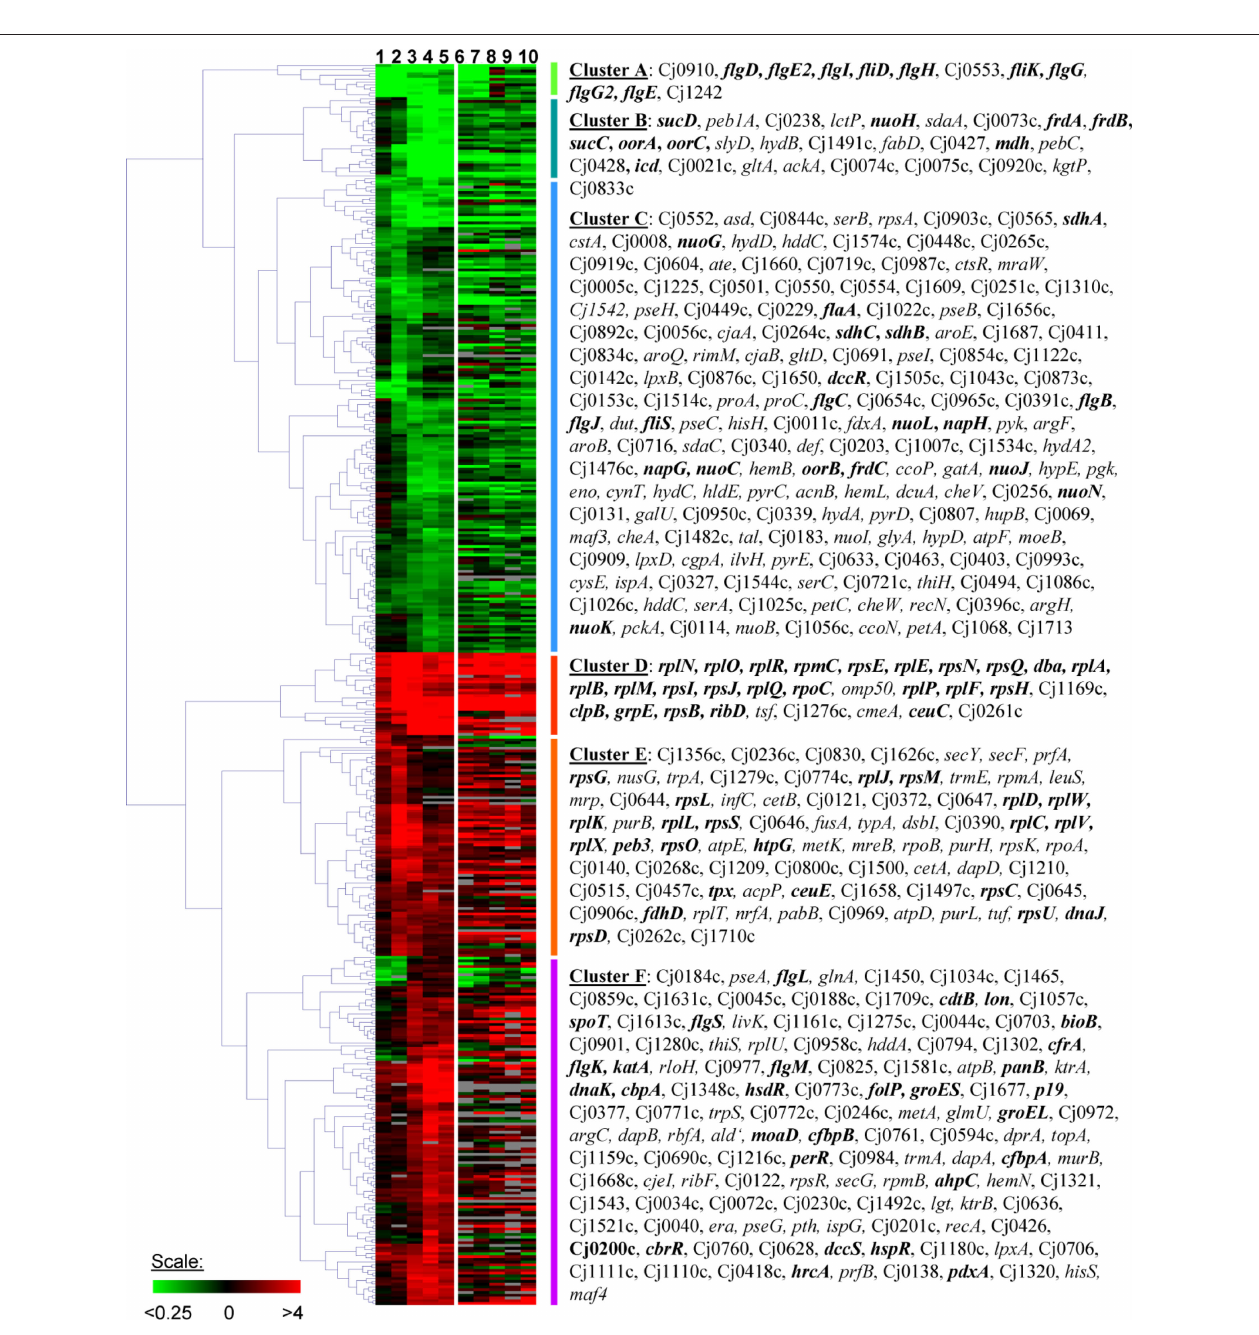
in the transcriptome for five different rabbits using the rabbit ileal loop model (as reported previously Stintzi et al., 2005) and are shown for comparative purposes between the two different host interaction models. The color intensity is proportional to the fold change as represented by the scale. Gray colors represent missing data. Genes in boldface are further discussed in the